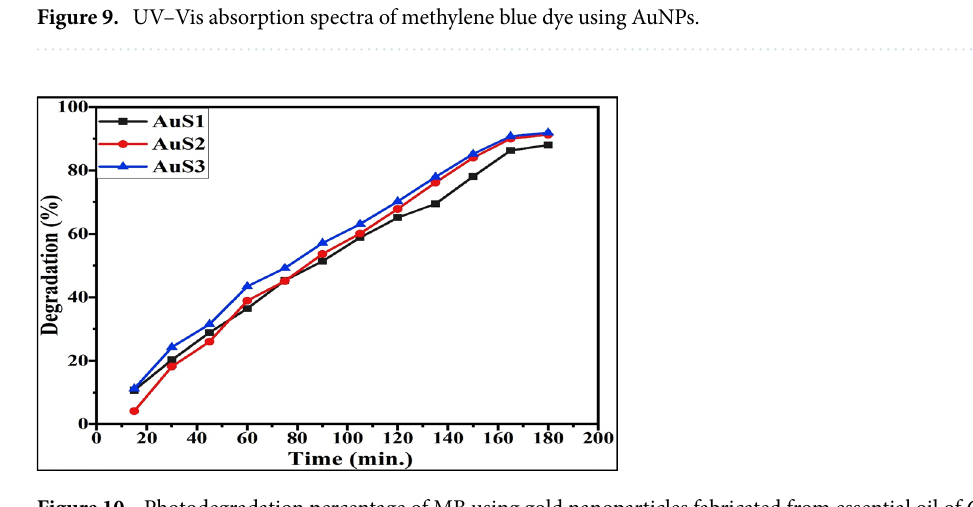
Figure 10. Photodegradation percentage of MB using gold nanoparticles fabricated from essential oil of C. flexuosus from different altitudes.